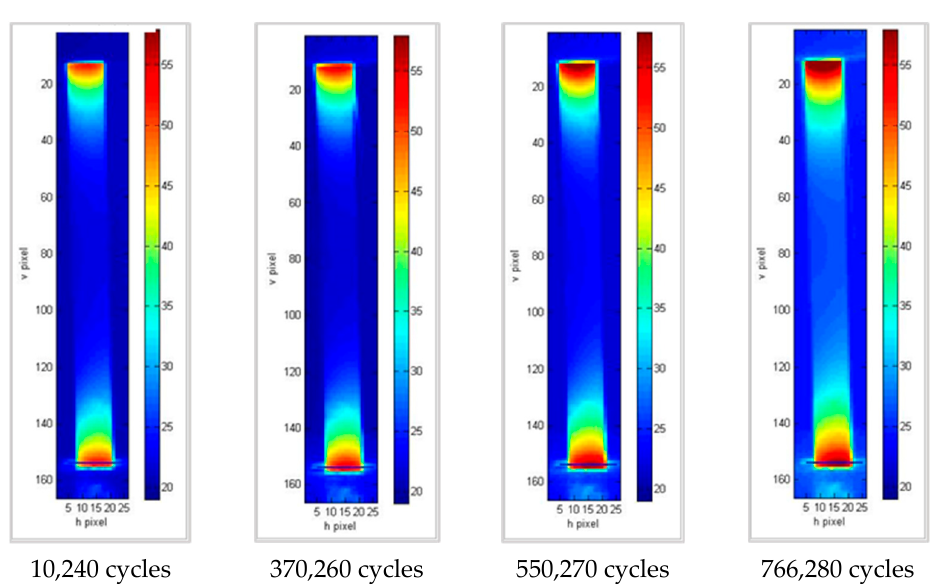
Figure 8. Thermograms at different loading cycles for specimen 14b. Table 4. Specimens analyzed by thermography and damage